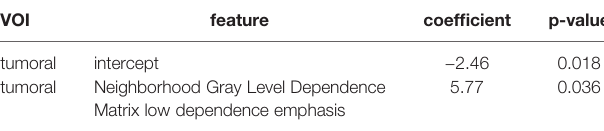
TABLE 2 | Details of the fi nal model for MGMT status